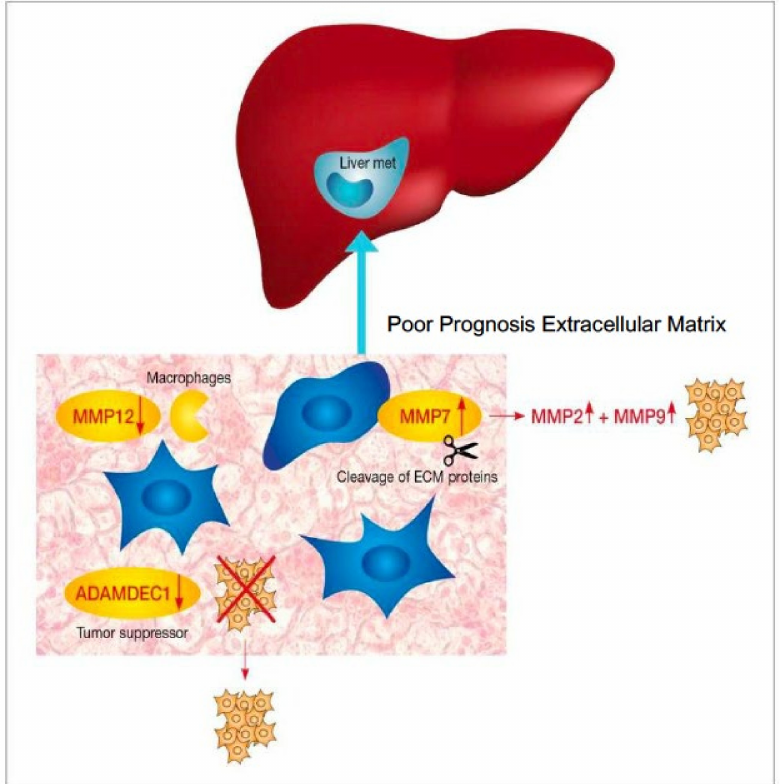
Figure 1. Scheme showing the “poor prognosis” microenvironment significant signature. In the “poor prognosis” microenvironment there is (i) Upregulation of MMP7 which promotes cancer invasion by proteolytic cleavage of ECM proteins and activation of cell proliferation through upregulation of MMP2 and MMP9 and (ii) Downregulation of the protective effect of MMP12 and the tumor suppressor,